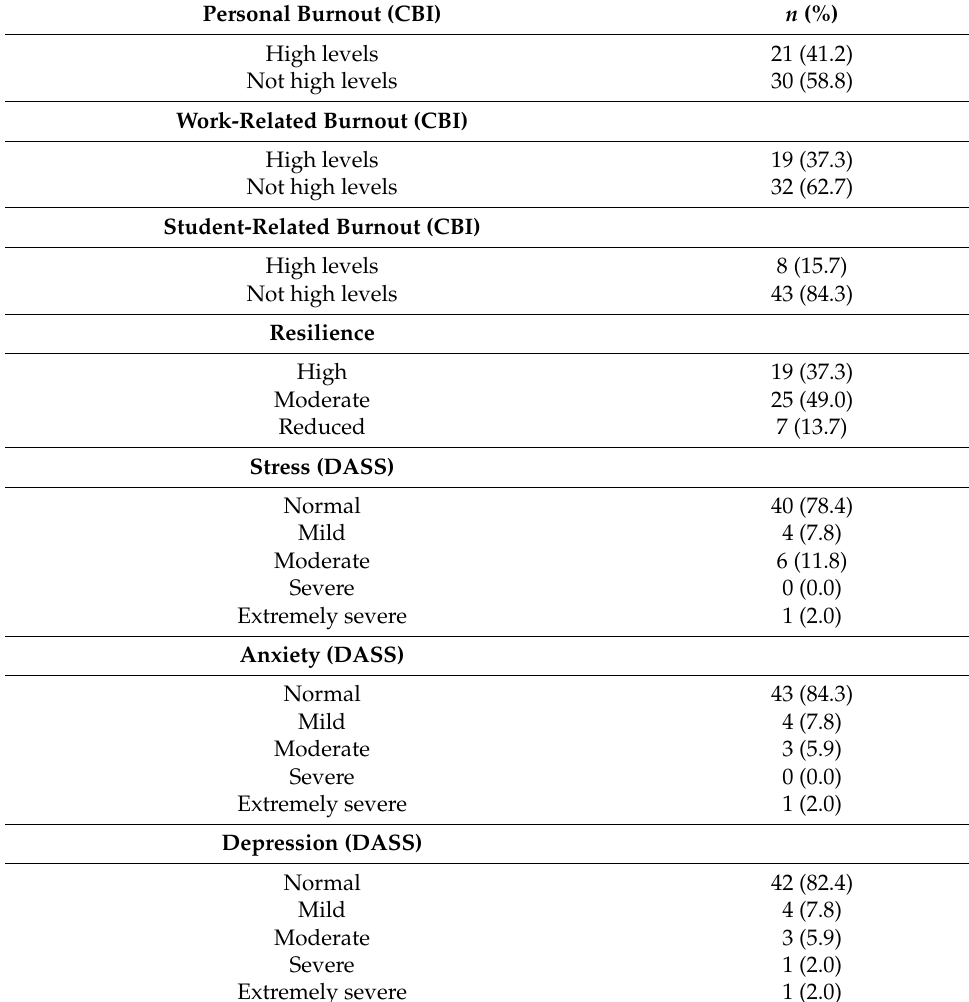
Table 2. Burnout, resilience, stress, anxiety, and depression